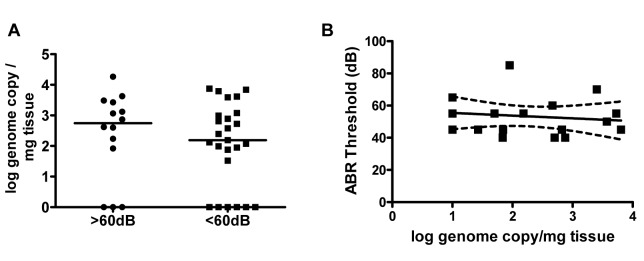
Hearing loss in MCMV infected mice is not correlated with virus load in the cochlea.
(A) MCMV log genome copies/mg tissue in cochlea from mice with ABR thresholds >60dB (median 71dB; n = 14) and ABR thresholds <60db (median 45dB; n = 25) at PNd42. Groups did not differ in quantity of viral DNA in cochlea (Mann-Whitney, p = 0.42). Note that results from some cochlea were below limits of detection of PCR and therefore indistinguishable from mock infected cochlea. These were plotted as log = 0 to permit statistical comparison of groups. (B) Linear regression analysis of ABR thresholds versus genome copies in cochlea (n = 18 mice). There was no correlation between viral genome copy number and hearing (p = 0.59, slope not significant from 0).